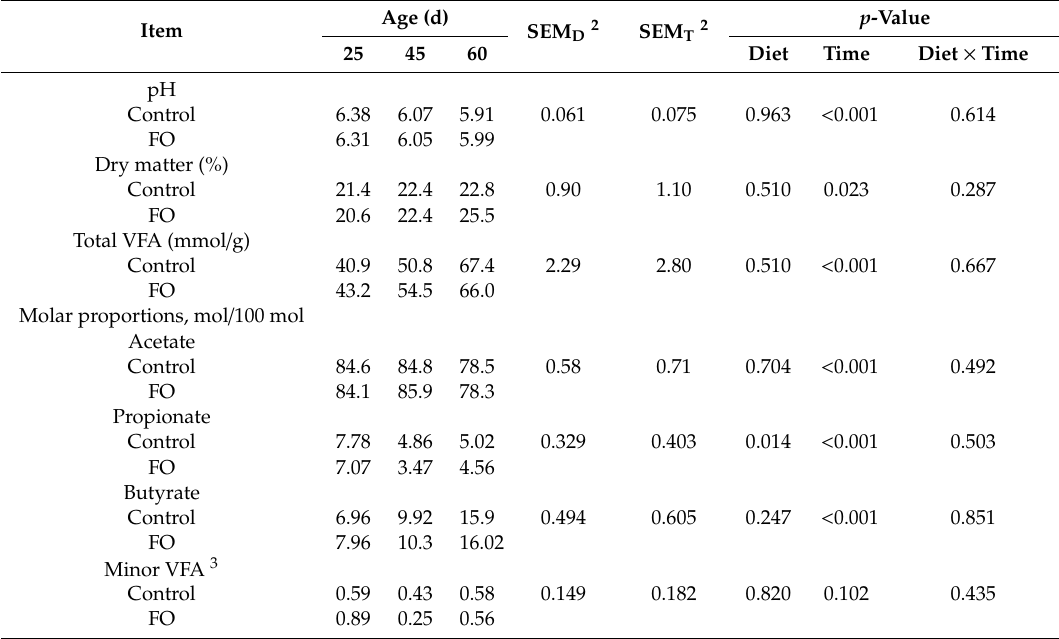
Table 6. Values of pH, dry matter content, and volatile fatty acid (VFA) concentrations in the cecum of growing rabbits fed diets with either lard (control) or fish oil (FO) as the fat source and slaughtered at 25 (weaning), 45, and 60 days of age 1